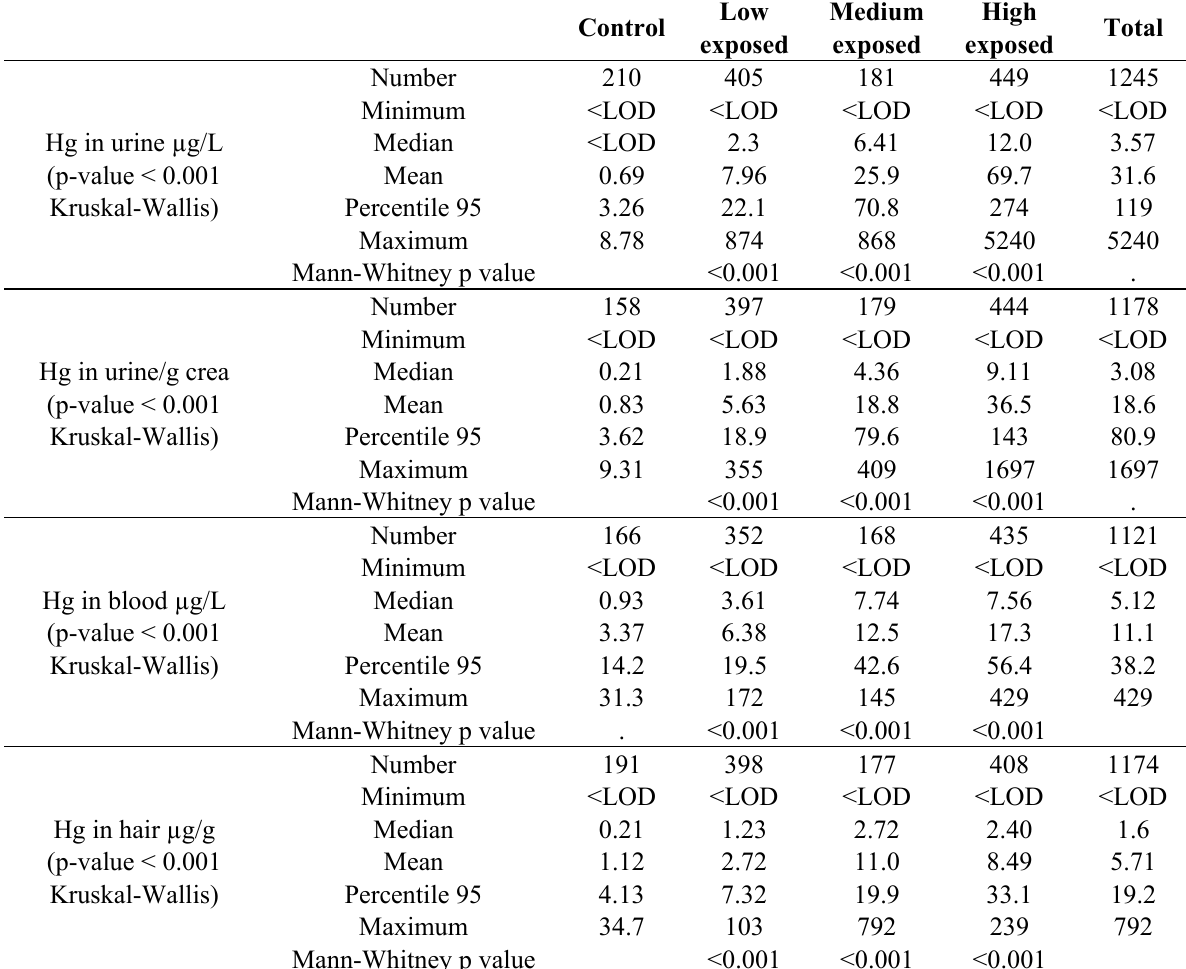
Table 4. Exposure subgroups and Hg in human